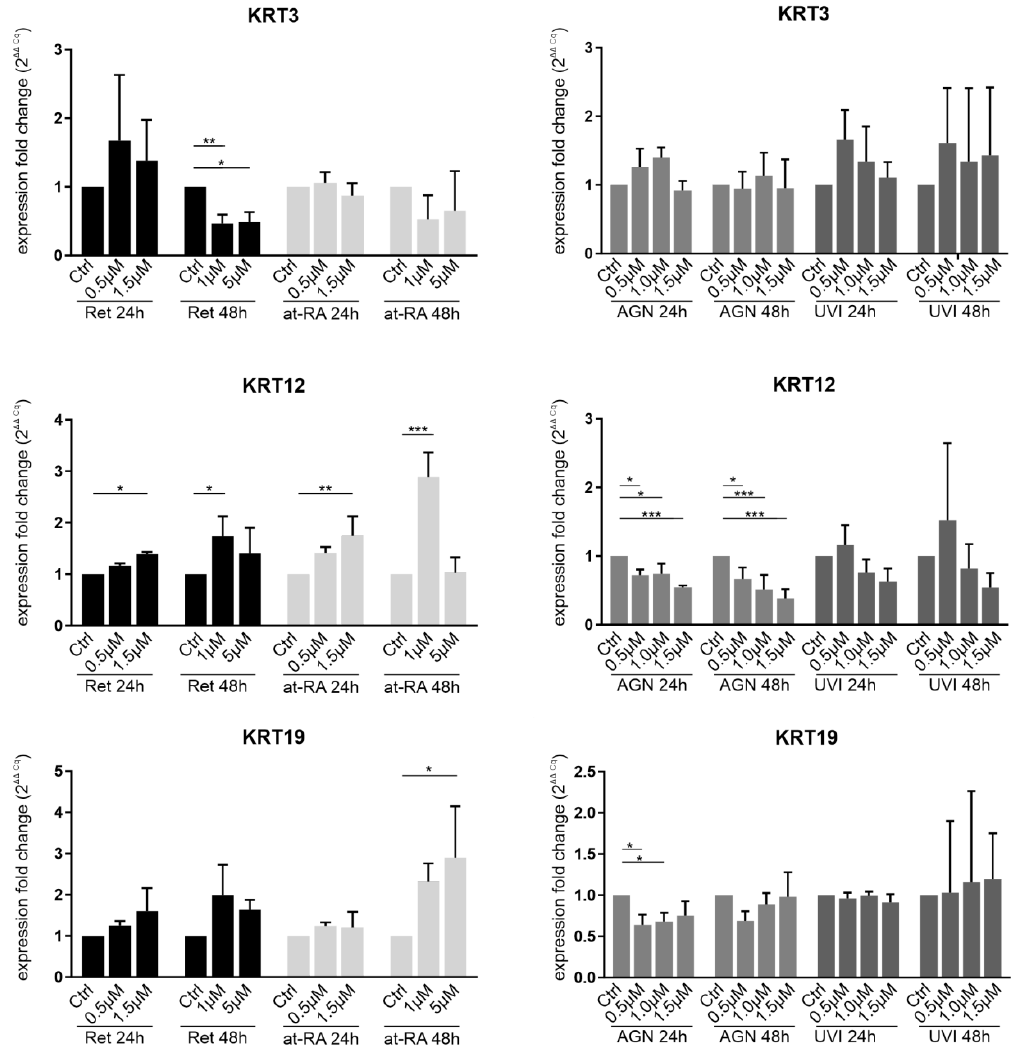
Figure 5. qRT-PCR analysis of KRT3, KRT12, and KRT19 transcripts in primary limbal epithelial cells (LEC) treated with retinol (Ret), all trans-retinoic acid (at-RA), AGN 193109 (AGN), or UVI 3003 (UVI) for 24 h and 48 h. The transcripts shown here are related to the corneal (KRT3/KRT12) and limbal/conjunctival epithelial phenotype (KRT19). Expression fold changes (FC) are calculated relative to each control using the ΔΔCt method. * p ≤ 0.05; ** p ≤ 0.01; *** p ≤ 0.001; n = 3.